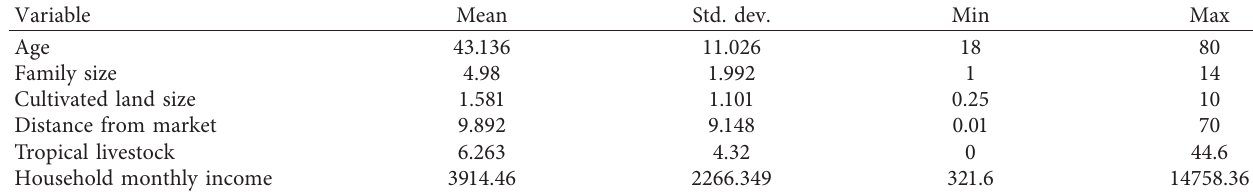
Table 2: Summary statistics for continuous